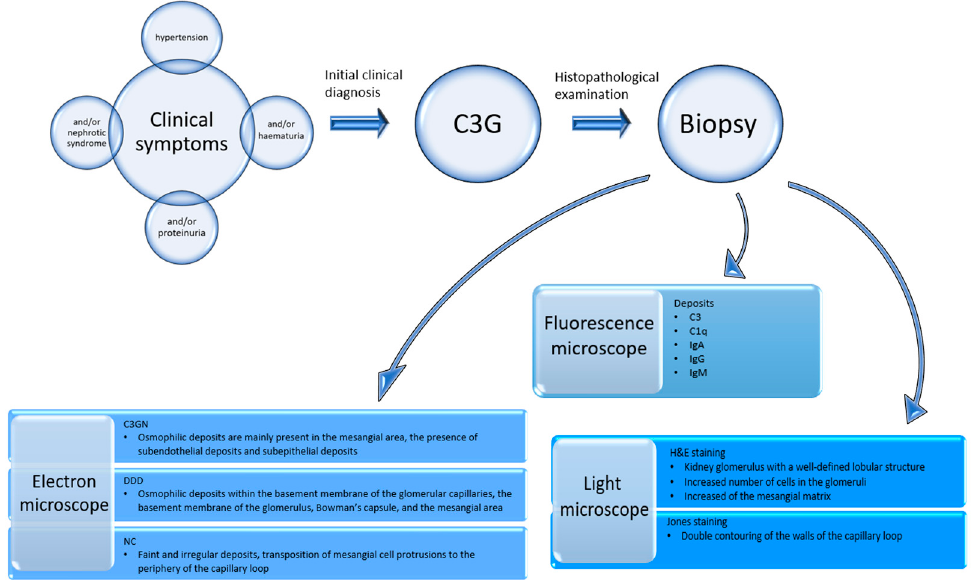
Figure 1. Diagram of the study fl ow. G3GN, C3 glomerulonephritis; DDD, dense deposit disease; NC, non-classi fi ed group; C3, C1q, complement component; IgA, immunoglobulin A; IgG, ease; NC, non-classified group; C3, C1q, complement component; IgA, immunoglobulin A; IgG, immunoglobulin g; IgM, immunoglobulin M. immunoglobulin g; IgM, immunoglobulin